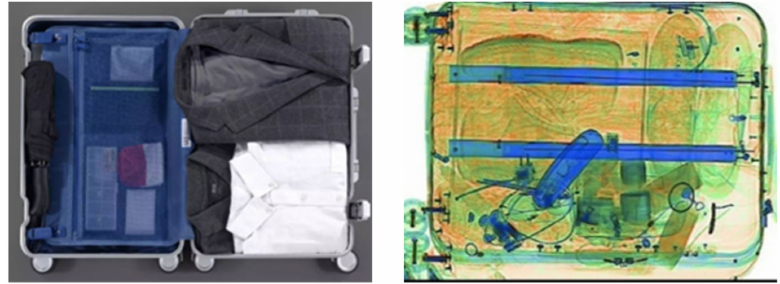
Figure 5. ( Left ) Normal scene. ( Right ) X-ray